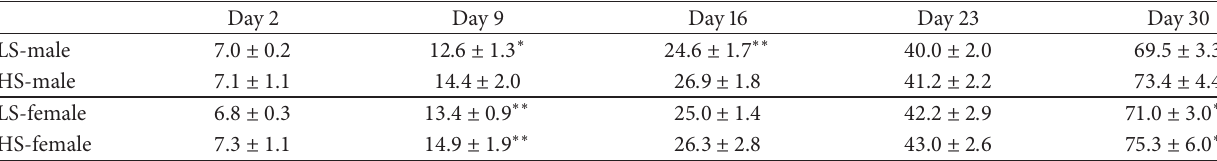
Table 3: Body weights of pups during lactation.